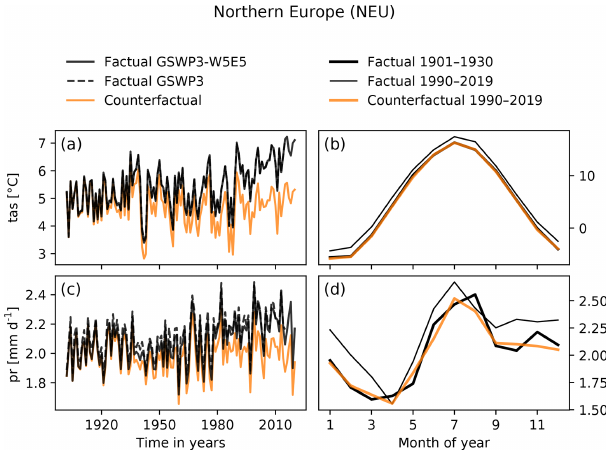
Figure 10. Same as Fig. 7 but for precipitation over the Tibetan Plateau